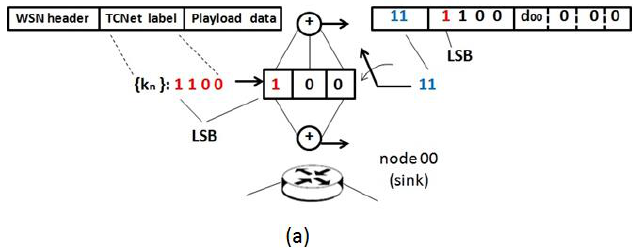
Figure 5. Example of hard decision used by state ( n – 10) to decide on a trellis branch, based on received sequence